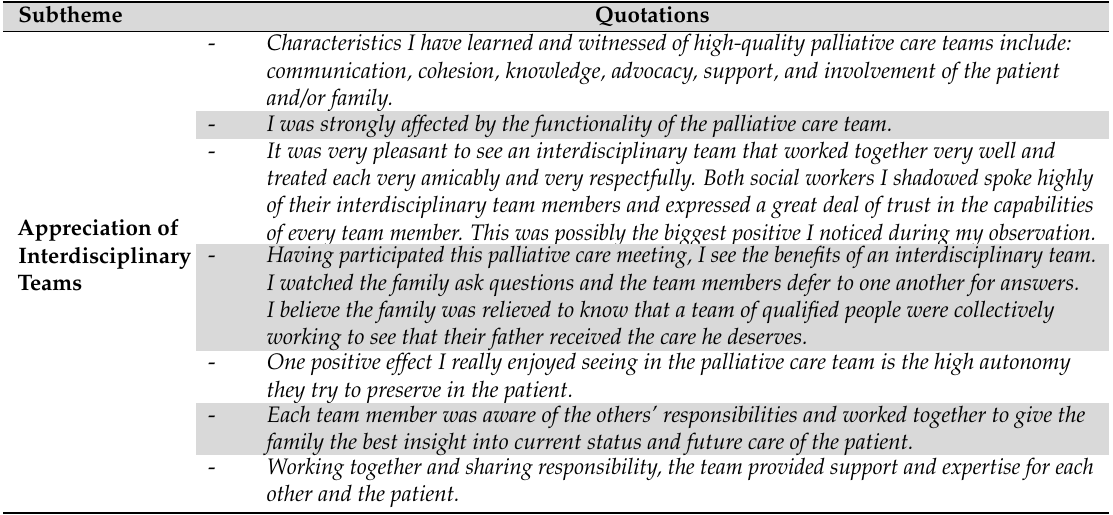
Table 1. Quotes related to the subtheme of appreciation of interdisciplinary teams.